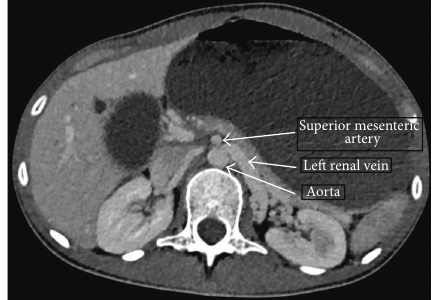
Figure 4: Axial CT section demonstrating the anatomy of Nut- cracker